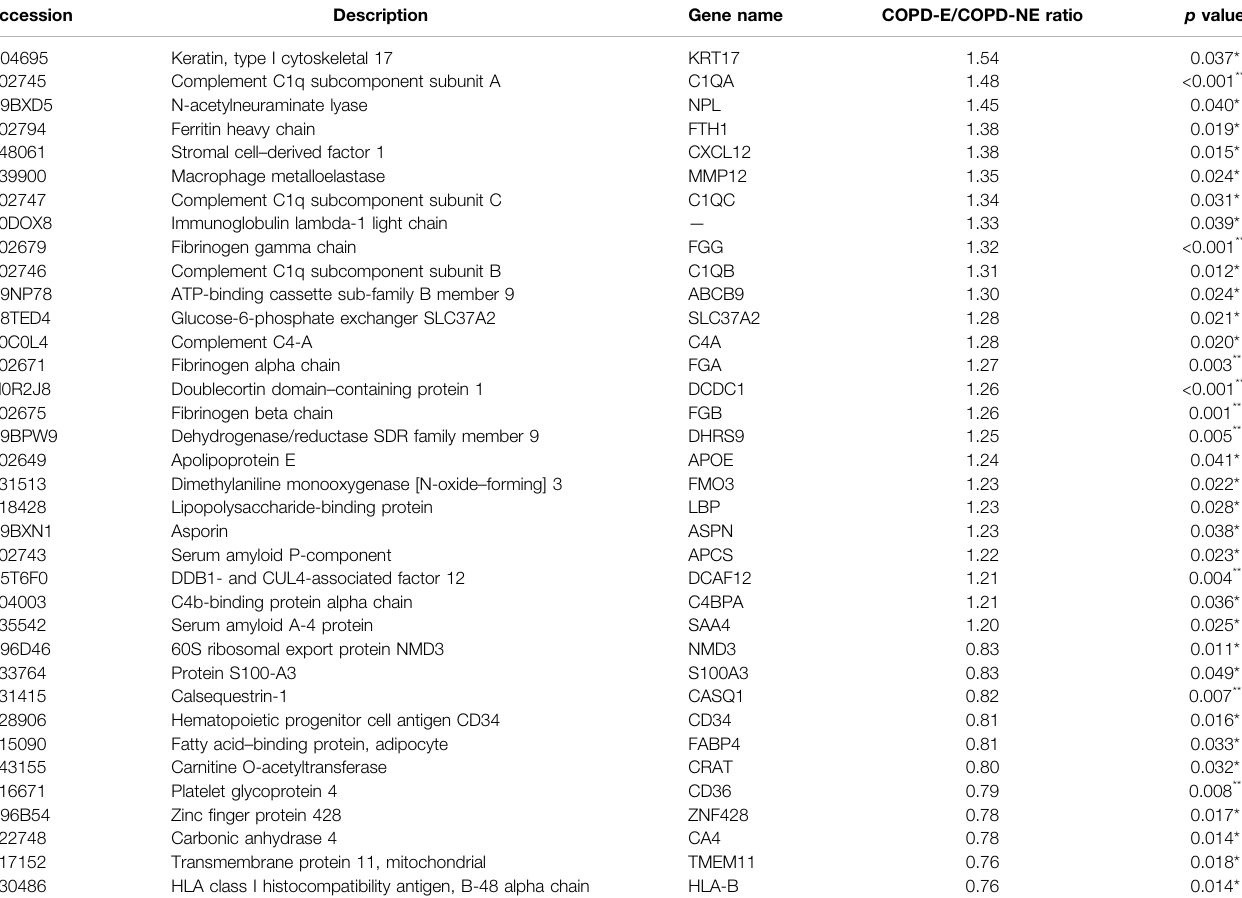
TABLE 4 | Differential abundant proteins in the COPD-E and COPE-NE